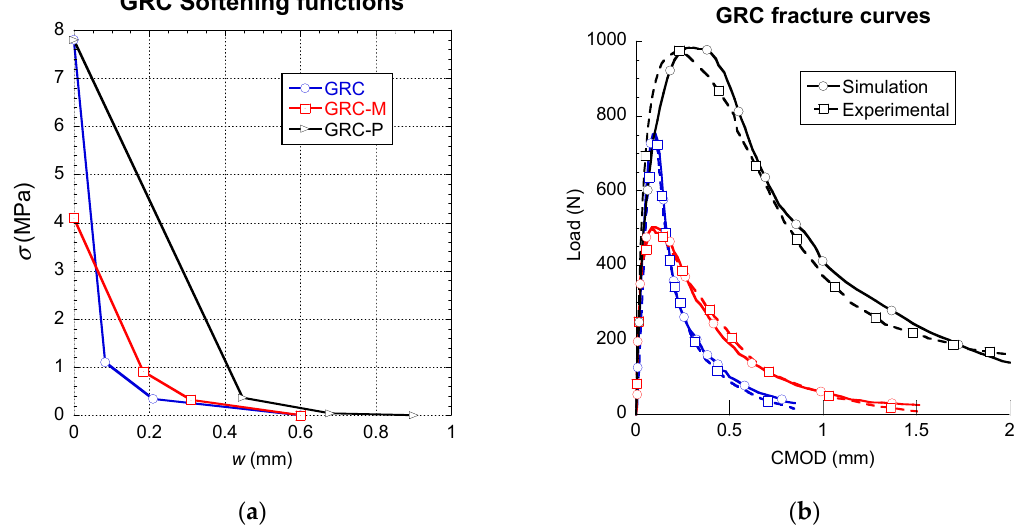
Figure 6. Softening functions ( a ) and comparison of simulated and experimental results ( b ).